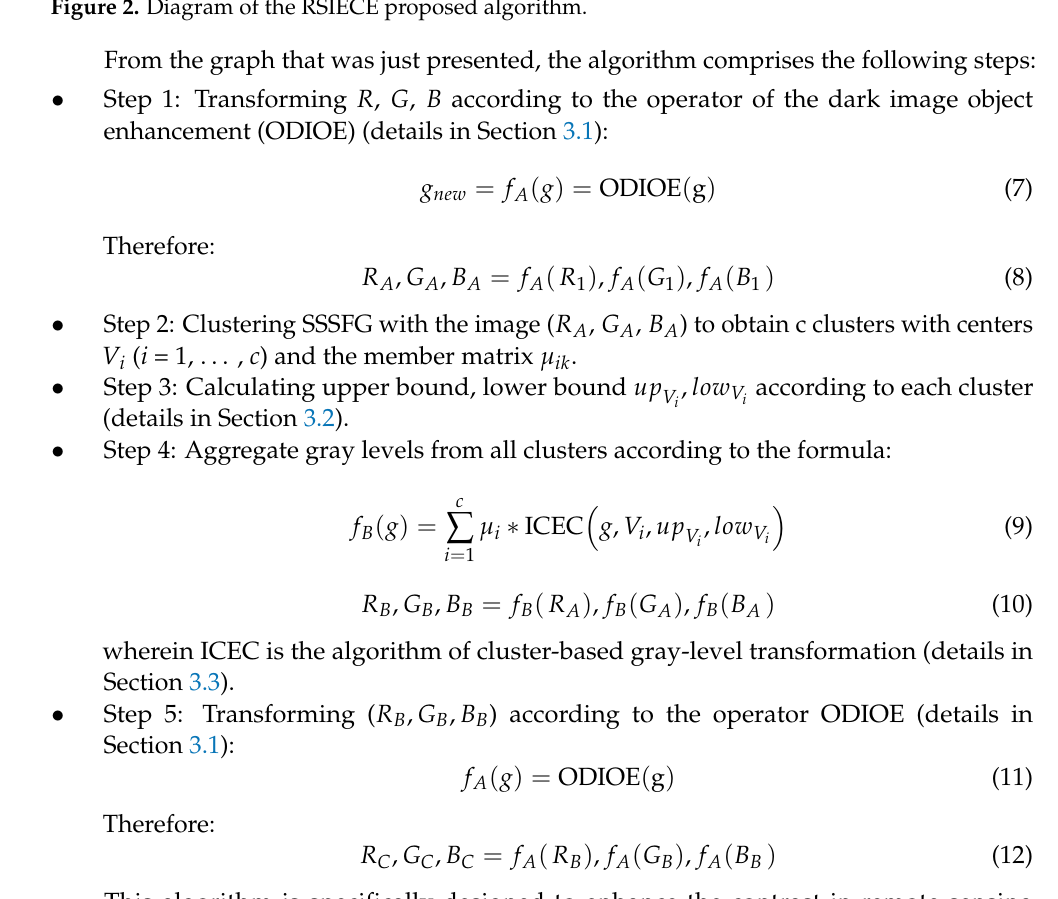
Figure 2. Diagram of the RSIECE proposed algorithm.